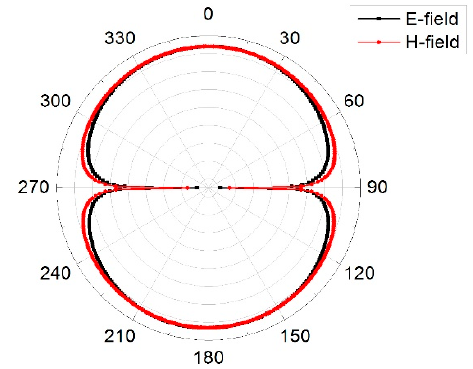
Figure 17. Radiation pattern for mode 2 at 5.8 GHz.